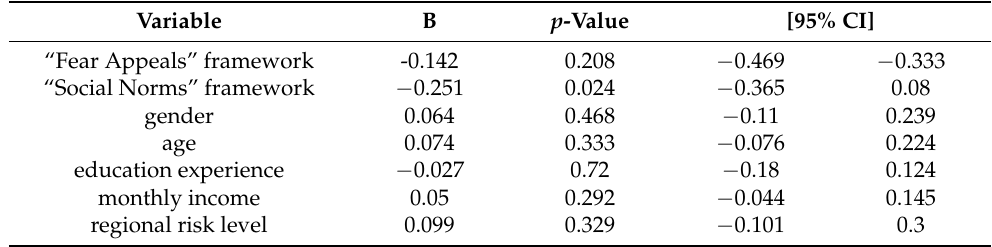
Table A4. Linear regression model of perceived threat on risk communication frameworks, n = 165.